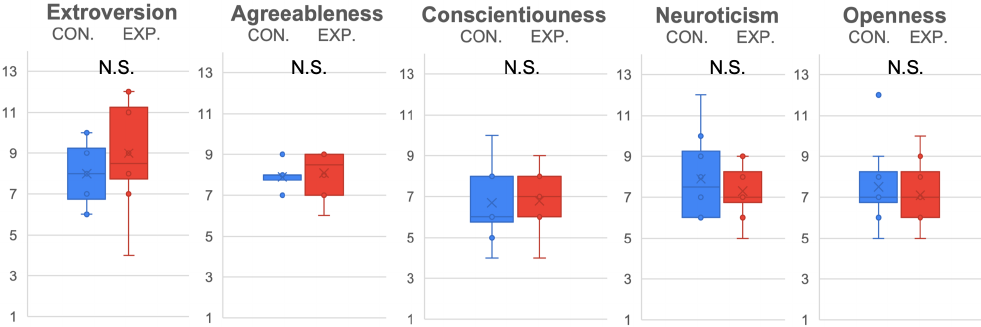
Figure 9. Personality evaluation of ERICA with Big Five by male subjects. * indicates the found significant difference, while N.S. indicates there is no significant